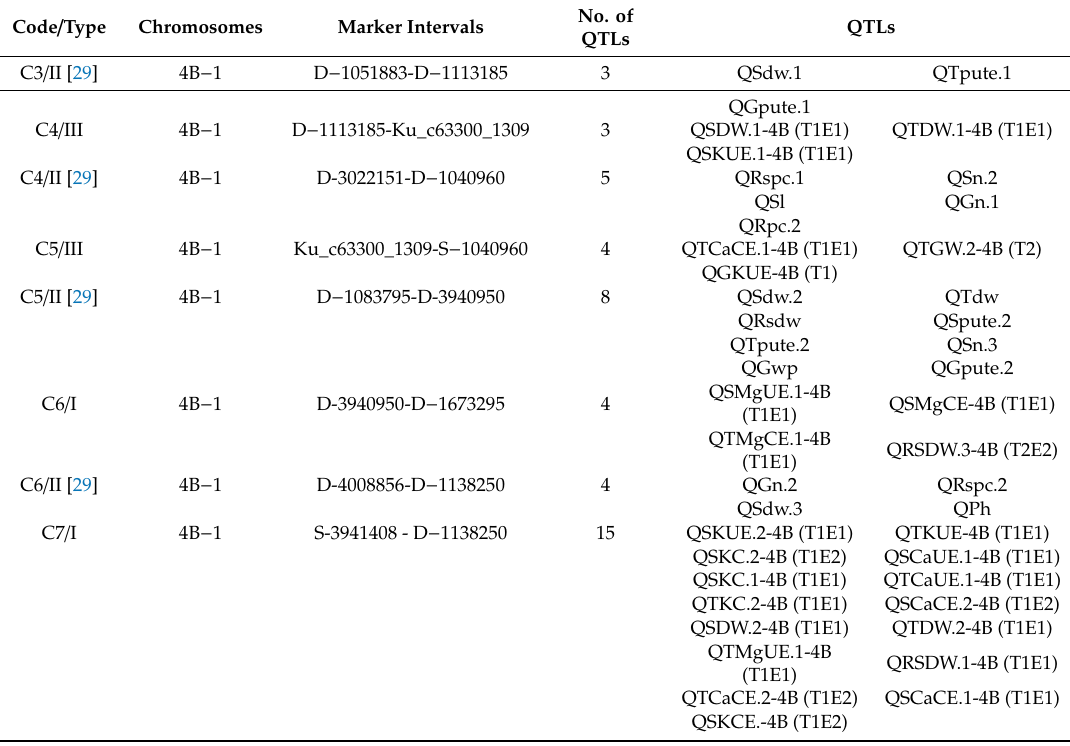
Table 6. QTL clusters detected in the same or adjacent marker regions in this paper and in Yuan et al. [29]. Code / Type Chromosomes Marker